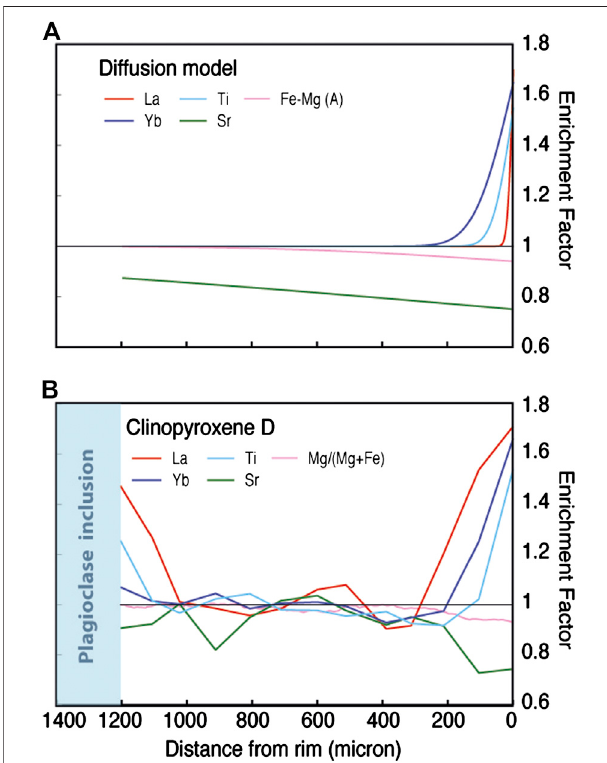
FIGURE 7 | Diffusion model (A) compared with trace element pro fi les of Cpx D (B) . Panel (A) models the diffusive in fl ux of selected elements into Cpx from a surrounding melt. The resulting compositional pro fi les track the post- diffusionconcentrationCrelativetotheconcentrationsinthemeltC0.An essential characteristic of this and all comparable diffusion models is the contrasting diffusion length generated for different elements. In panel B actual data for the compositional pro fi les of Cpx D are plotted as the “ Enrichment Factor ” ,whichistheconcentrationatagivenpointofthepro fi ledividedbythat of the crystal core (here set as the 600 – 800 μ m interval), and directly comparable to C/C0 in Panel A . A critical observation in (B) is that, in marked contrasttoessentialrequirement ofthediffusionmodel, thedifferent elements in Cpx D co-vary at the same places along the pro fi les, and that La varies over signi fi cantly larger distances than can be accounted for by diffusion.